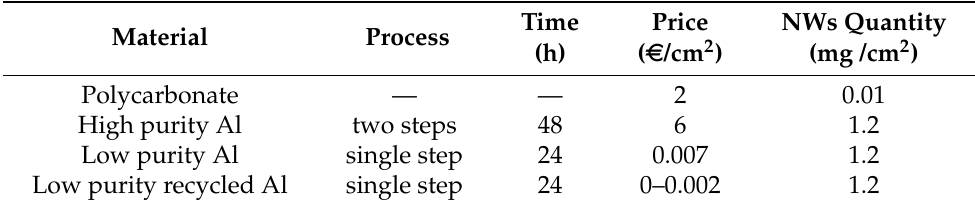
Table 1. Material, synthesis procedure, synthesis time and price for three different nanoporous templates and quantity of NWs